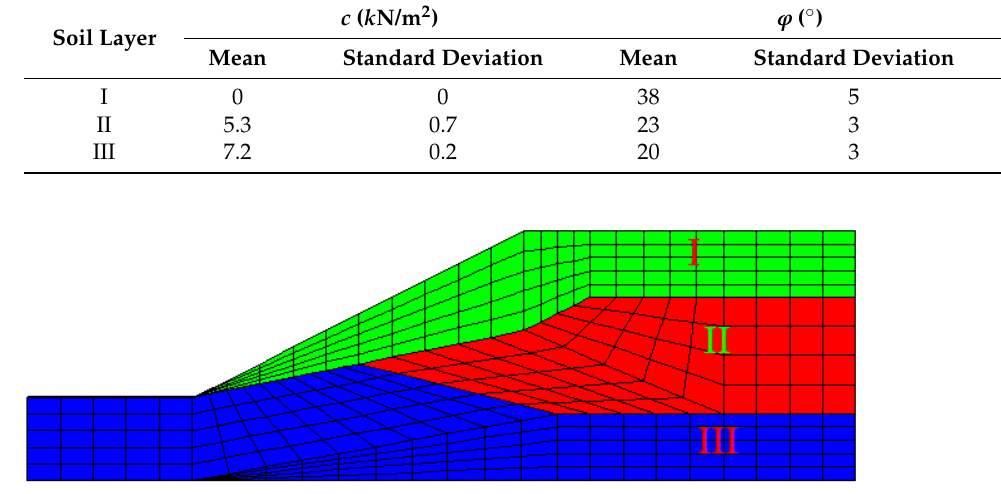
Figure 12. The relationship of running times and number samples. (I, II, III denote three different soil layers). Table 9. The statistics property of random variables.